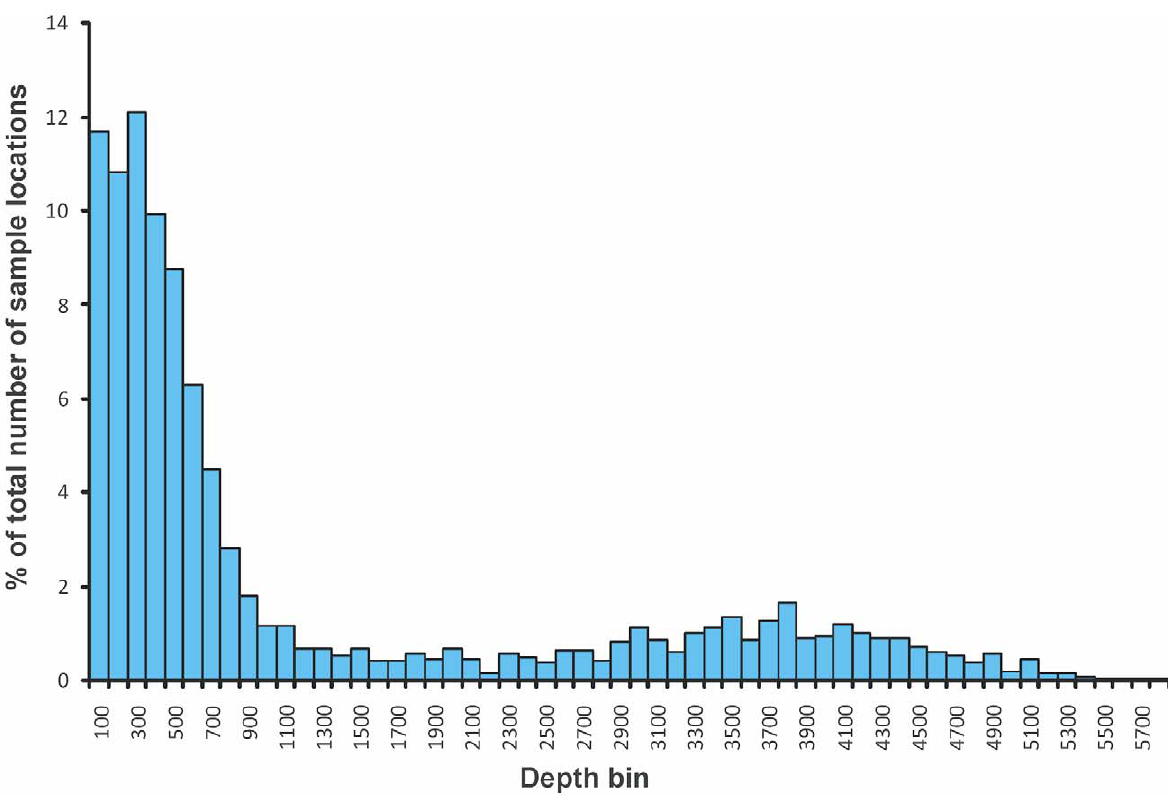
Figure 6. Depth distributions of Southern Ocean benthic samples. The percentage of benthic sample depths from SCAR-MarBIN found at 100-m interval depth bins.